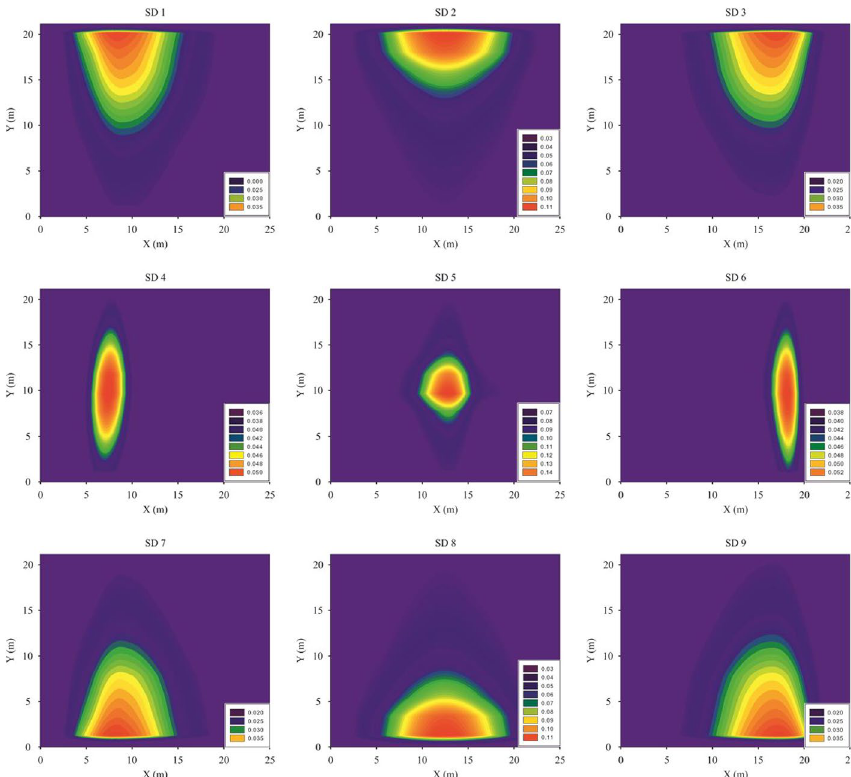
Fig. 12 Two-dimensional view of the detected damage extent for 9 single damage scenarios in noise-free